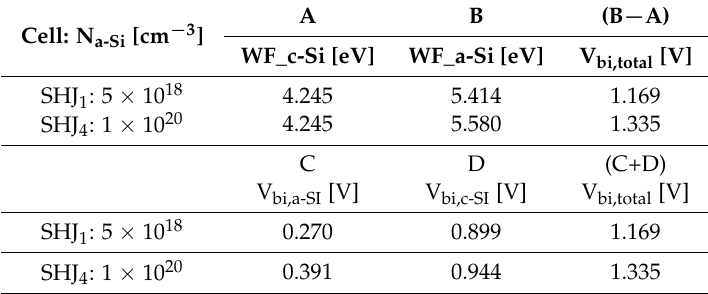
Table 1. Built-in potential and its components in cells SHJ 1 and SHJ 4 at